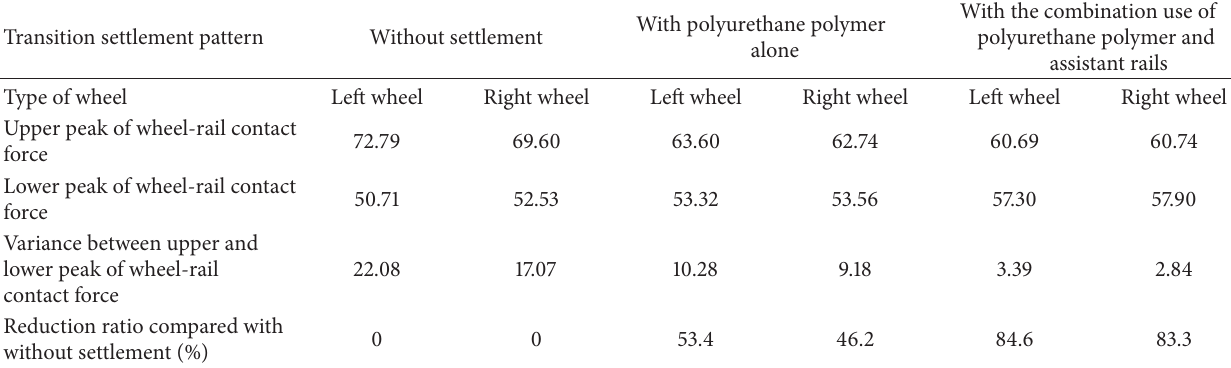
Transition settlement pattern Without